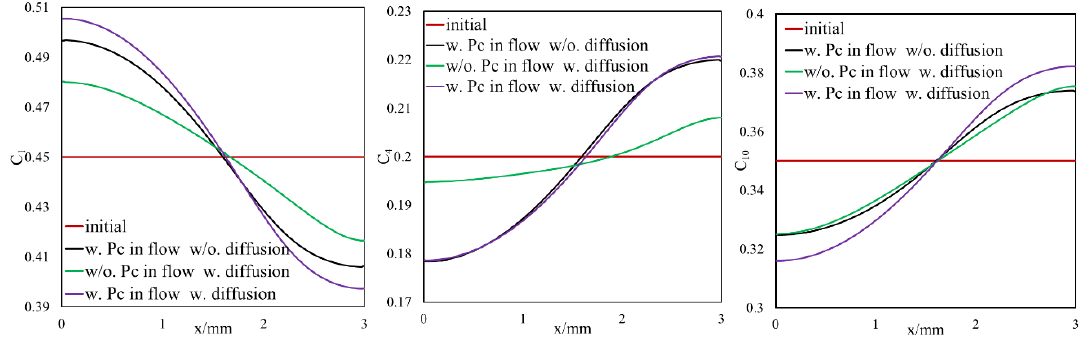
Figure 14. The overall composition profile, with Pc in flow without diffusion vs. without Pc in flow with diffusion vs. with Pc in flow with diffusion, 100 days, ternary mixture.